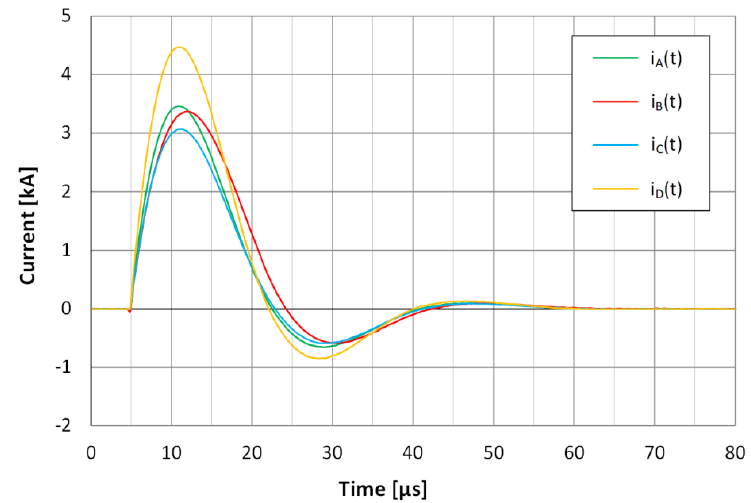
Figure 6. Current distribution in the CFRP1 specimen during the test with the first lightning-type impulse simulating the return stroke component.